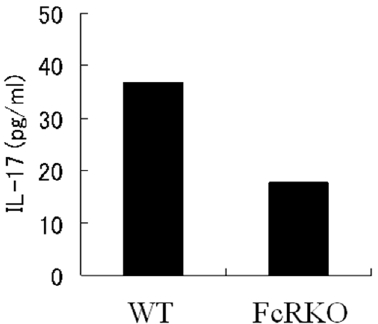
Figure 2. Histopathology of ankle joints from arthritic IL-17KO and WT mice. Arthritis was induced as described in the legend for figure 1 and the mice were sacrificed at days 7 and 21 after initial serum transfer. H&E stainings of ankle joints are shown (scale bar represents 100 m m).